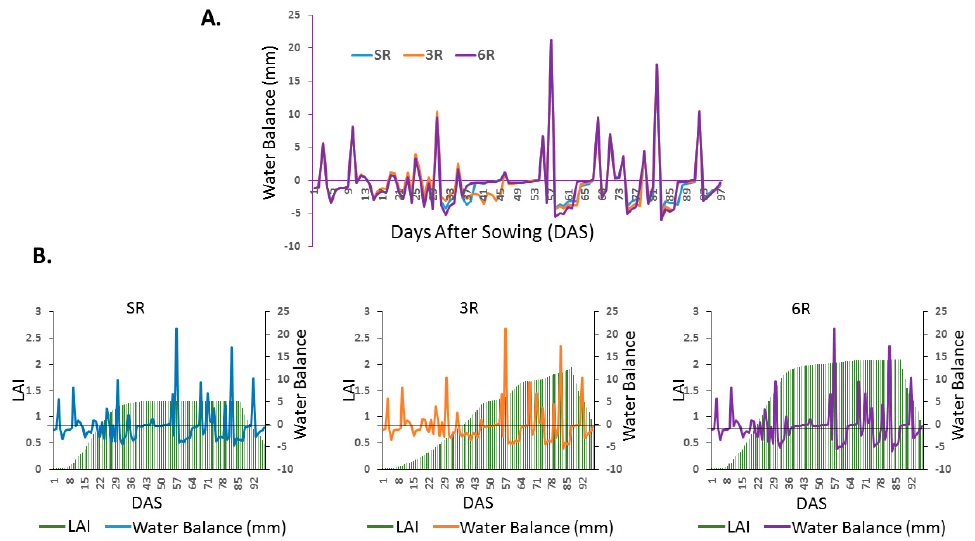
Figure 7. Water balance ( A ) and leaf area index (LAI) ( B ) for 2030 under climatic scenarios RCP4.5 for rainfed common bean cultivar Pinto Saltillo (growth habit III) under sowing densities of 90,000 (SR), 145,000 (3R) and 260,000 (6R) plants ha − 1 in the semi-arid temperate highland of Pabellon de Arteaga in Aguascalientes,